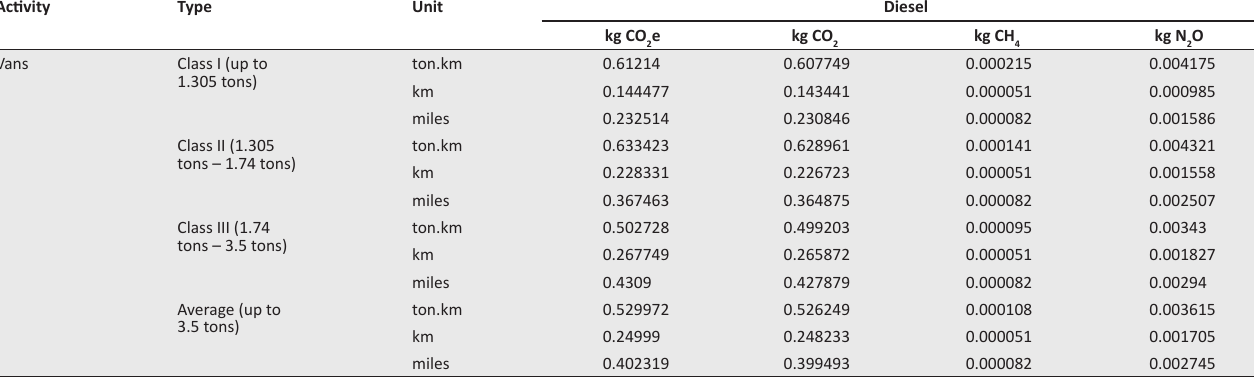
TABLE 9: Department of Environment, Food and Rural Affairs’ carbon emission conversions for distribution. Activity